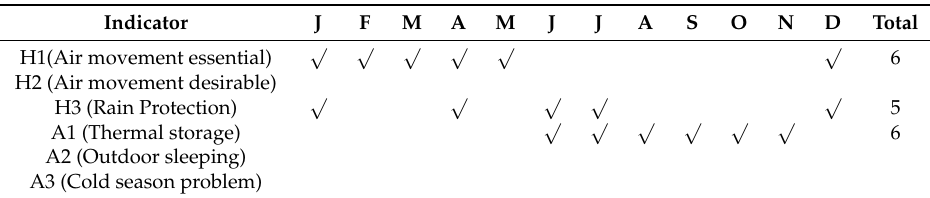
Table 11. Humid and arid